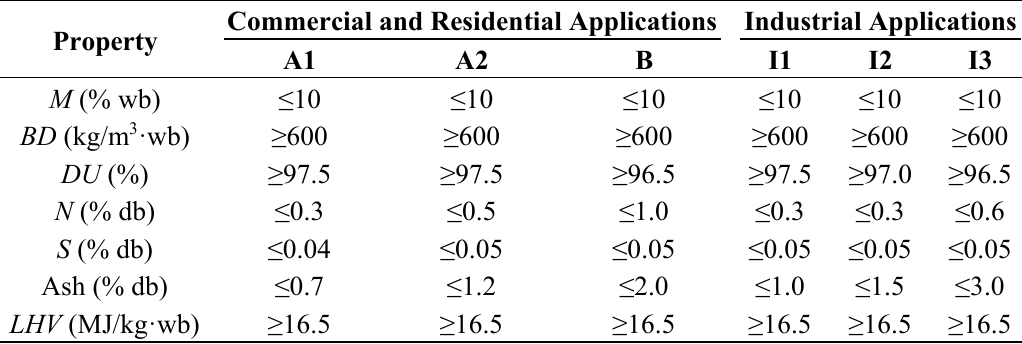
Table 2. Limit values for pellets from woody biomass.